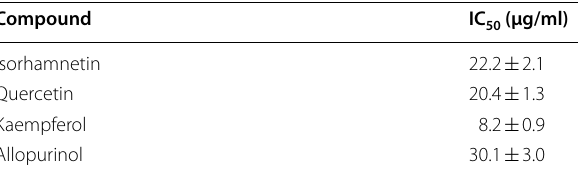
Table 3 XOD inhibitory activities of isorhamnetin, quercetin and kaempferol calculated as inhibitory concentration producing 50% inhibition (IC ) in 50